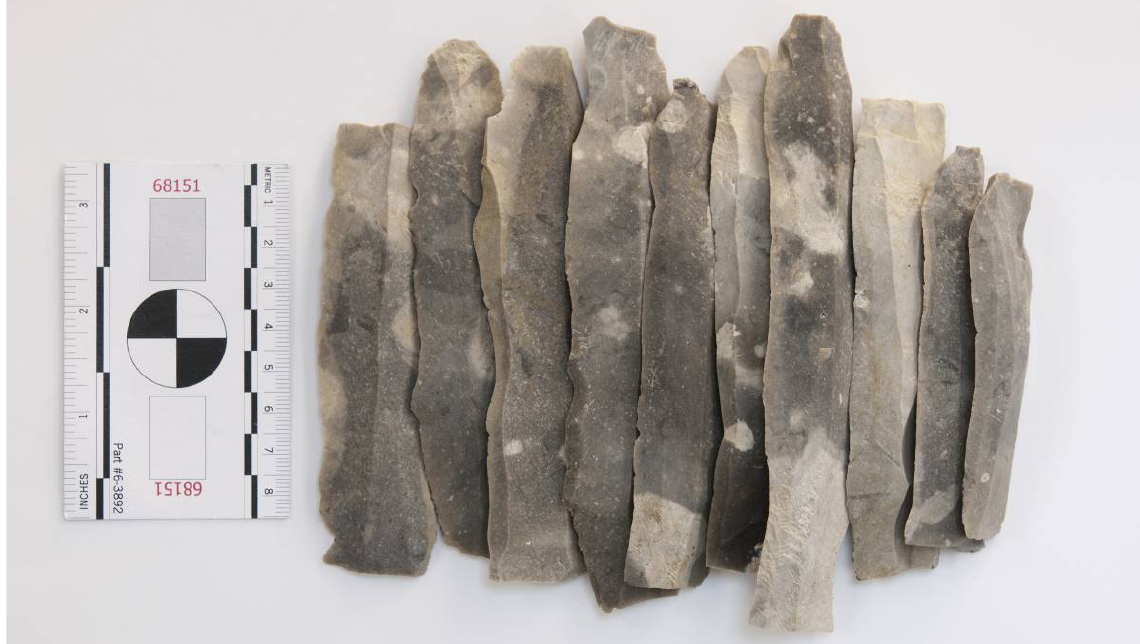
Figure 24. Spiennes, Camp-à-Cayaux. Flint blades abandoned on the mining site (1965 excavations by F. Hubert). Photo by M. Woodbury ,